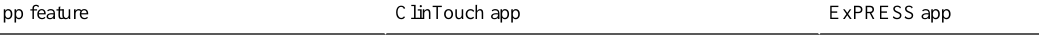
Table 1. Comparison of ClinTouch and ExPRESS app